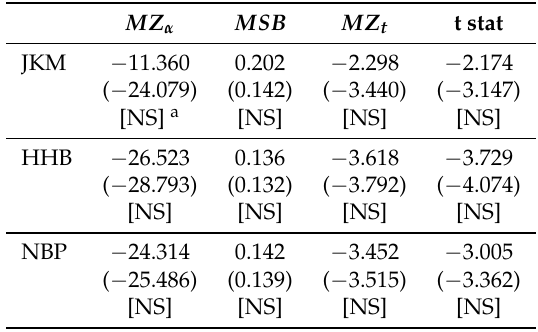
Table 2. Unit root test using [25] from January 2000 to December